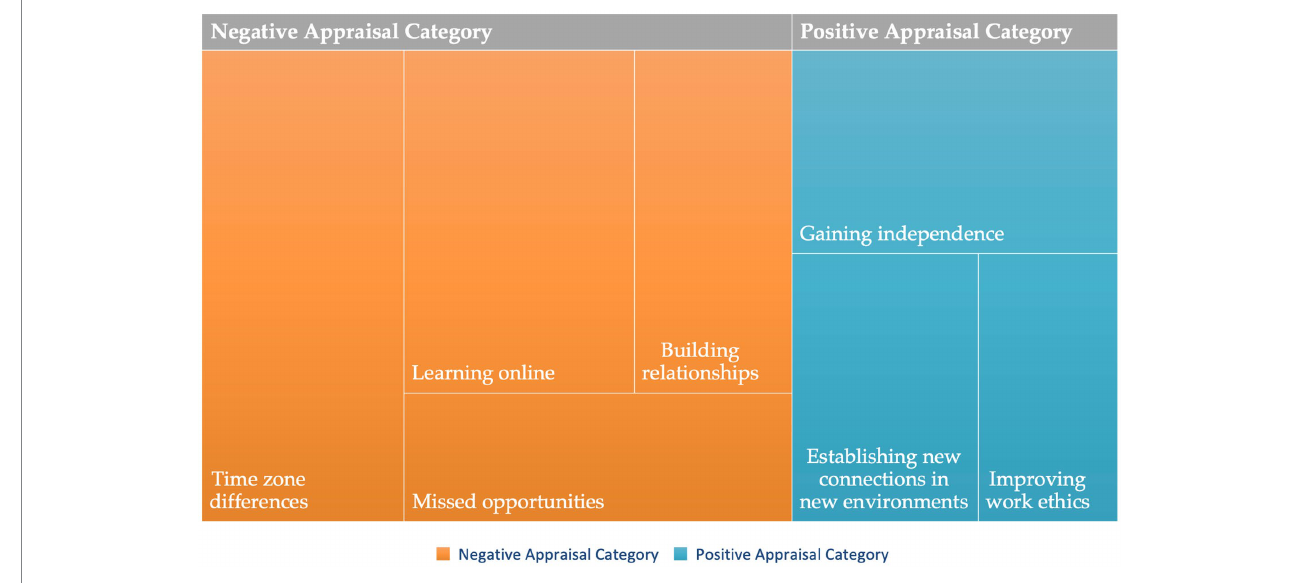
FIGURE 2 Appraisal codes